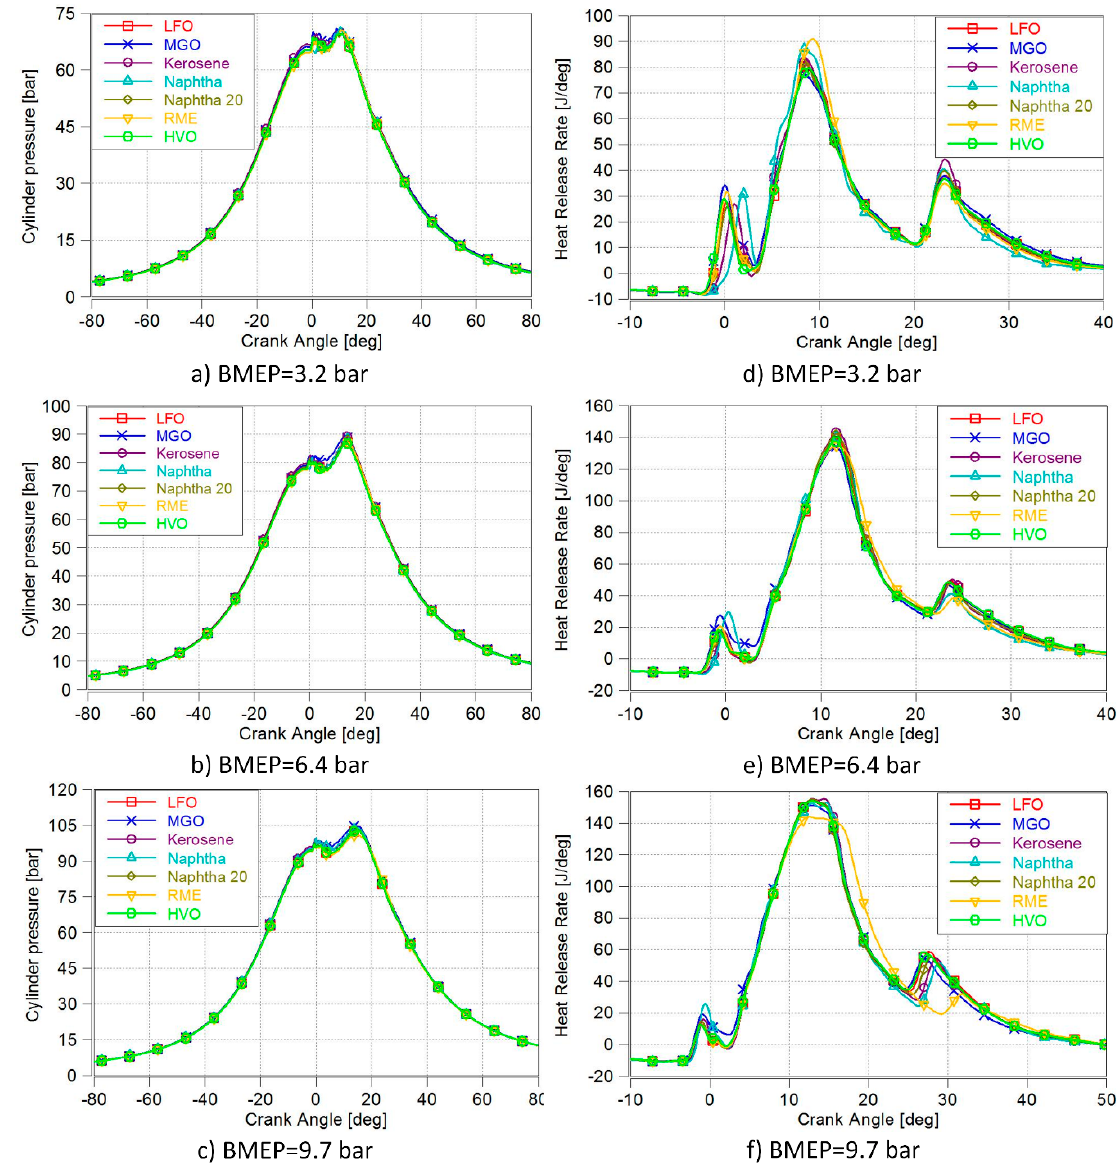
Figure 2. In-cylinder pressure and heat release rates at different engine loads.